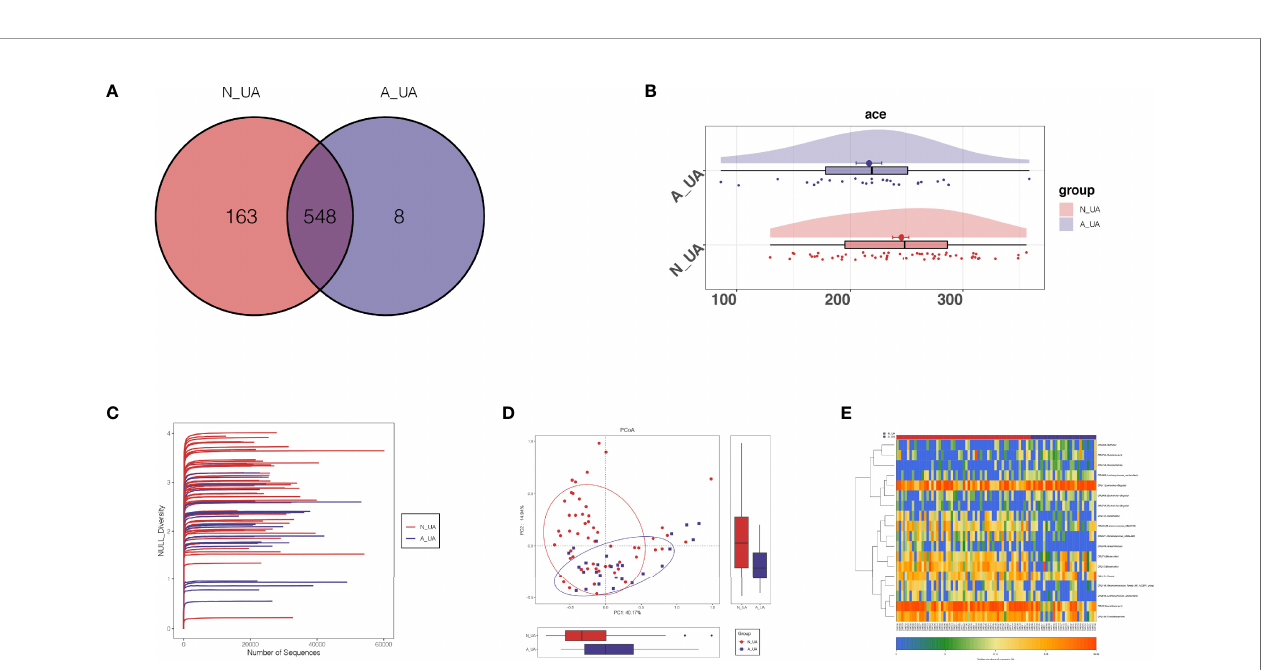
FIGURE 6 | The taxonomic and functional differences between the two groups in the subgroup analysis. (A) Shannon – Wiener curves showing estimated operational taxonomic unit (OTU) richness basically approached saturation in all samples, and the microbial diversity was lower in the A_UA group. (B) Venn diagrams showing OTU distribution in different groups. Ace index (p = 0.023; C ) showed that the richness of bacteria was lower in the A_UA group. (D) The b -diversity was visualized among the two groups in way of principal coordinates analysis (PCoA). (E) Heatmap showed 20 signi fi cantly different key OTUs between N_UA and A_UA.